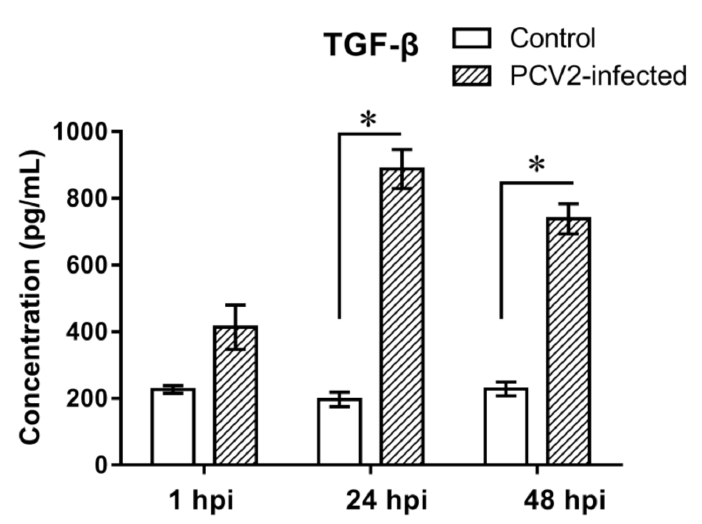
Figure 3. Expression of TGF- β at the protein level. TGF- β in the culture supernatants of control and PCV2-infected PAMs were measured by using porcine cytokine array kits. Data are expressed as pg/mL of three independent experiments. * represents p < 0.05.